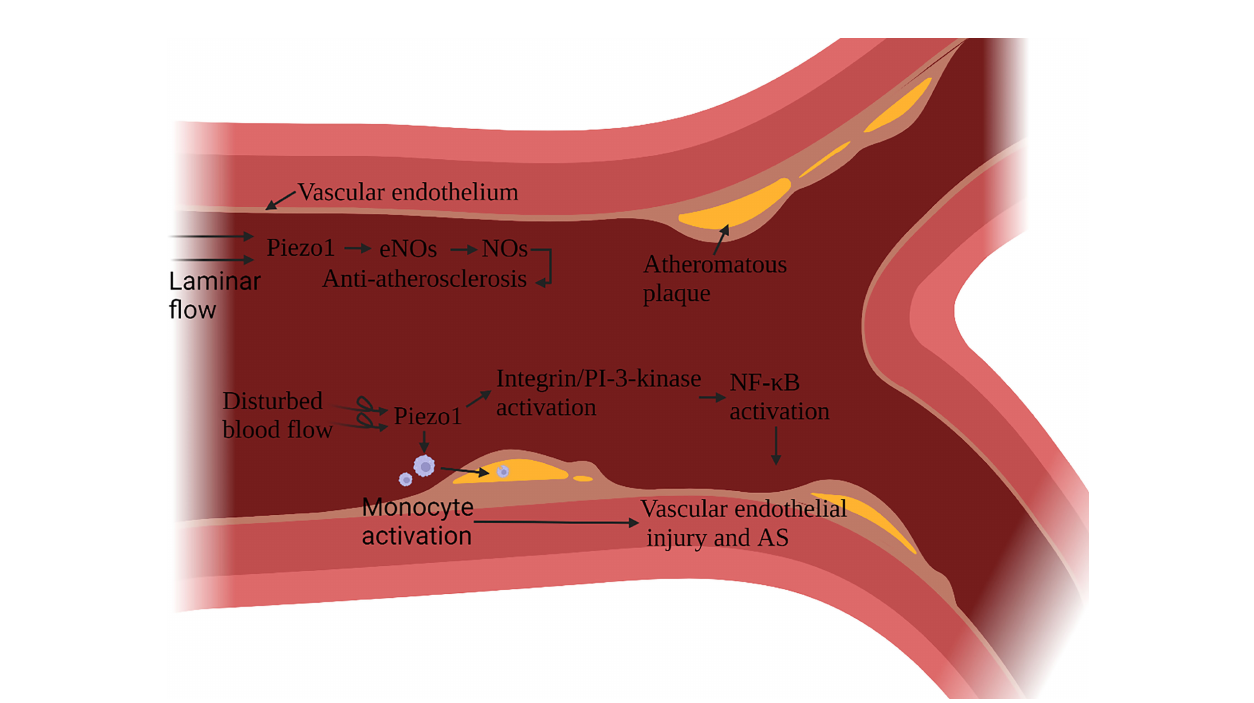
FIGURE 6 | Schematic diagram of the role of Piezo1 in atherosclerosis. Piezo1 on vascular endothelial cells senses the shearing force of blood fl ow, and laminar fl ow produces NO through Piezo1, which has the effect of protecting vascular endothelium. Disturbed blood fl ow shear force activates Piezo1, activates in fl ammatory pathways through integrin activation and PI3K-related signaling pathways to cause vascular endothelial in fl ammation, reduces eNOS activation, and induces monocytes to accumulate to the injured site, accelerating the formation of atherosclerotic